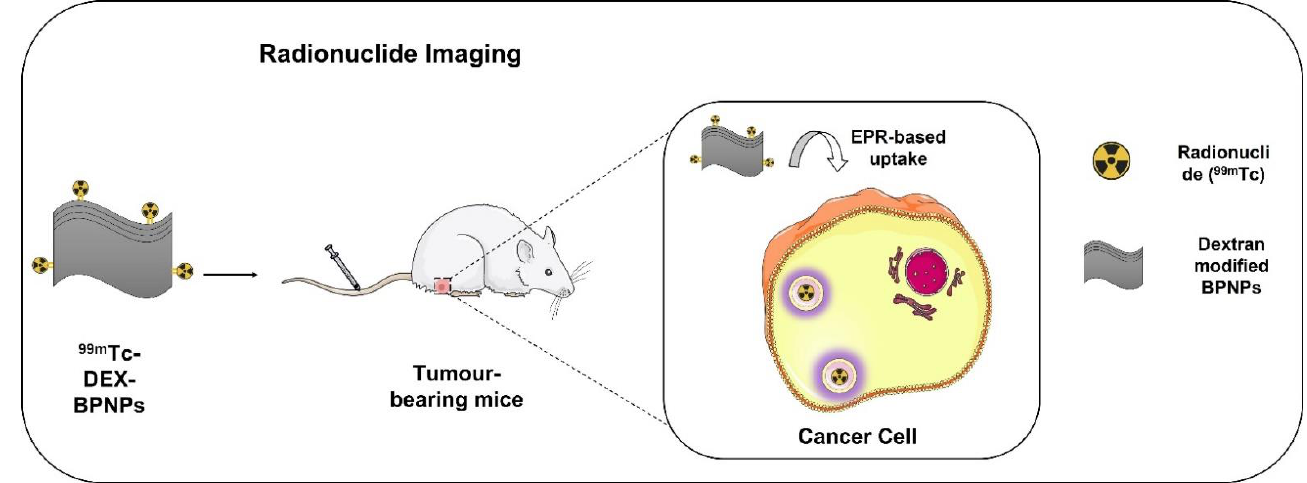
Figure 5. Radionuclide imaging of breast cancer cell using dextran-modified radiolabeled BP na- Figure 5. noparticles.